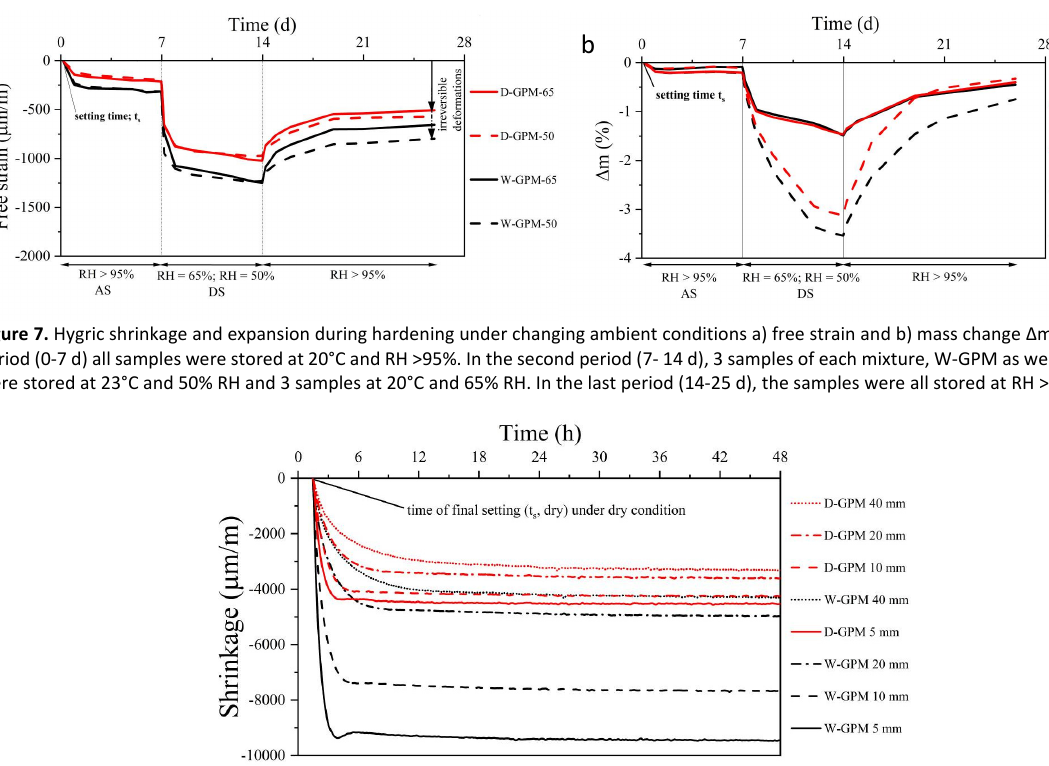
Figure 8. Shrinkage strains due to very early drying of freely moveable layers with different thickness of the wet ‐ cast (W ‐ GPM) and dry ‐ cast mix (D ‐ GPM). Layers were exposed to 23°C and 50% RH from time of setting on under dry conditions for the first 48 h. Table 3. Mean values, standard deviation and coefficient of variation of shrinkage strains of disc specimens acquired by DIC system at the time of 48 h of measurement. W ‐ GPM D ‐